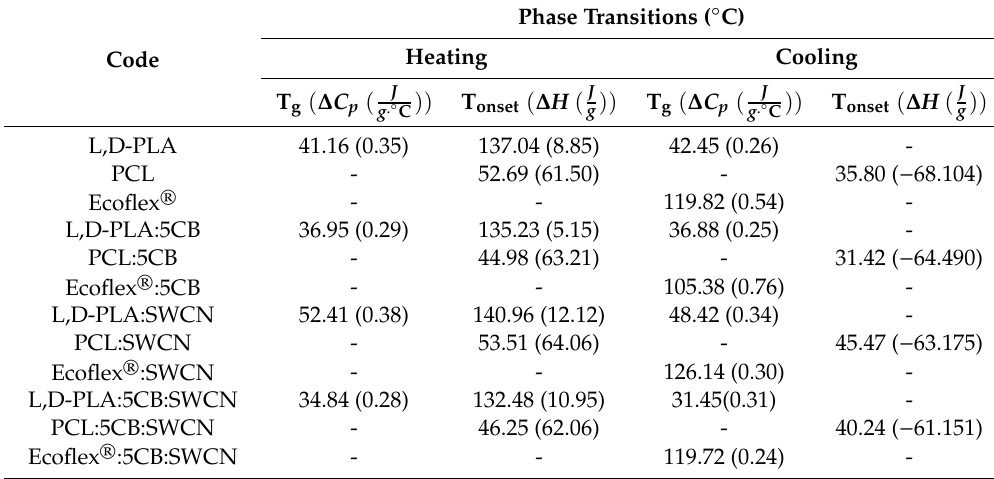
Table 1. Transition temperatures and enthalpy changes of the investigated compositions detected by di ff erential scanning calorimetry